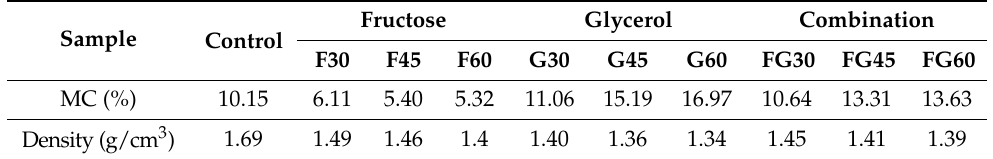
Table 1. Moisture content and density of biofilm at different concentrations of